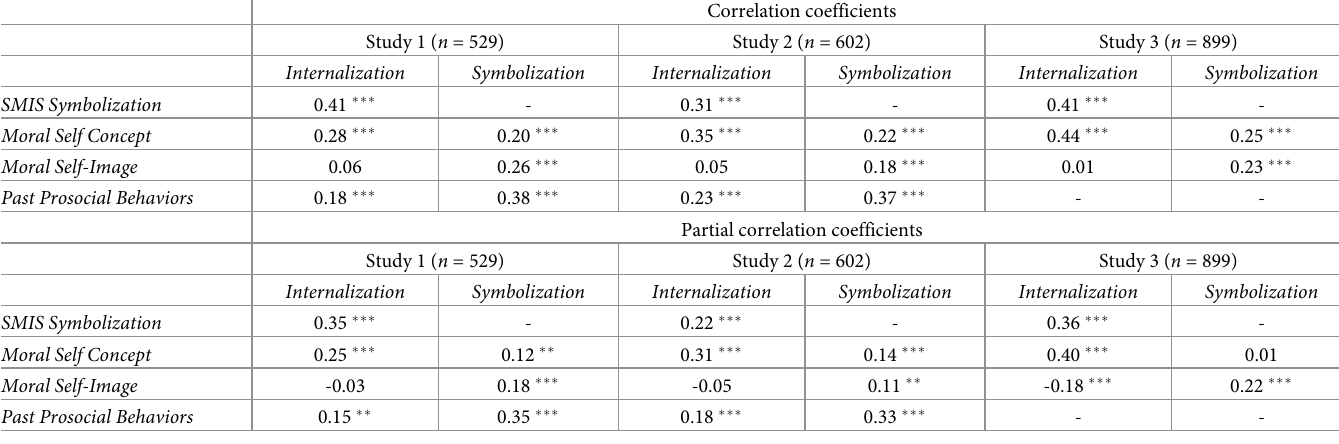
Table 4. Correlation and partial correlation coefficients of SMIS with MSC, MSI and PPB across Studies 1, 2 and